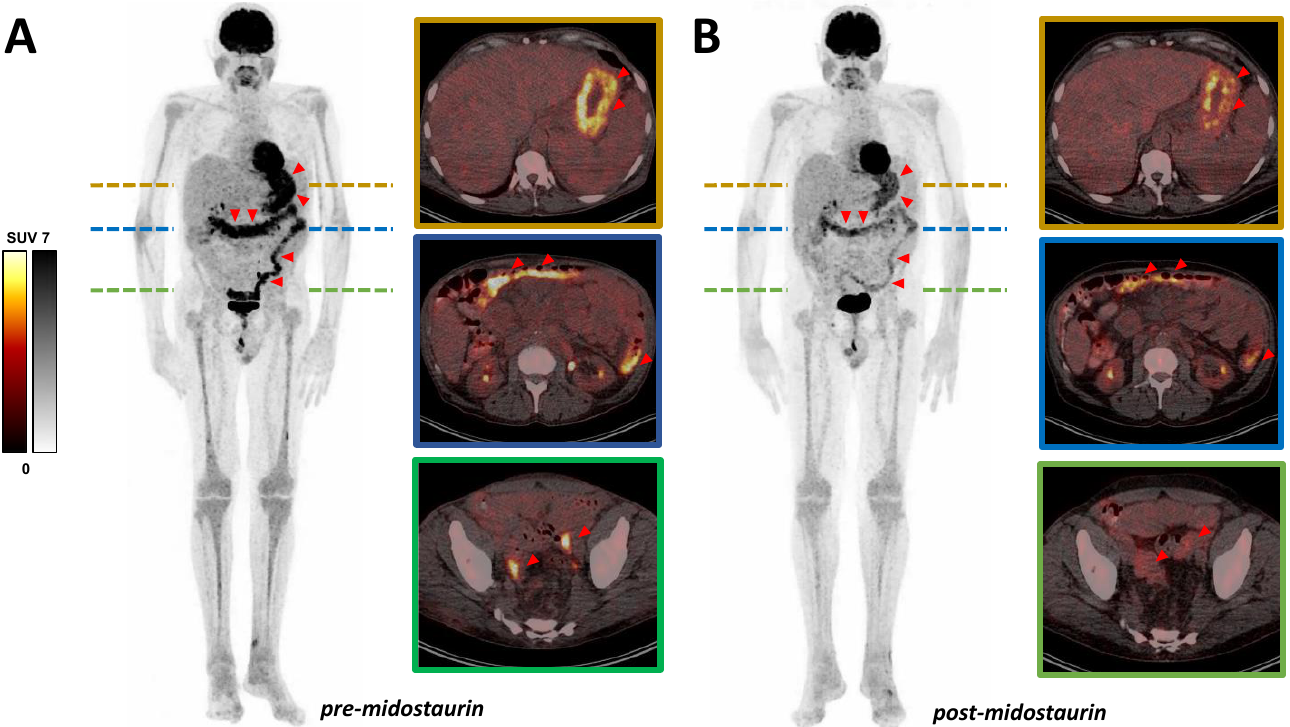
Figure 1. Declining uptake can be seen in presented MIP (maximum intensity projection) and exemplary transversal slices of [ 18 F]FDG PET/CT scan in gastrointestinal mastocytosis manifestations. ( A ) Baseline (blood glucose level: 87 mg/dL; hemoglobin: 11.2 g/dL) and ( B ) after 6 months’ therapy with midostaurin (blood glucose level: 103 mg/dL; hemoglobin: 11.5 g/dL). Exemplary SUV peak values (pre- vs. post-midostaurin treatment): in stomach 7.2 vs. 5.8 and in colon 6.4 vs. 3.4. Diffuse uptake in bone marrow was also slightly regressive (exemplary in the left tibia SUV peak 2.3 vs. 1.9), while splenomegaly remained similar. Red triangles exemplarily point to gastrointestinal mastocytosis